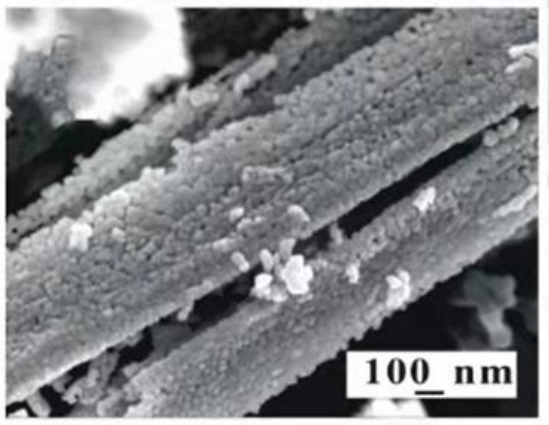
Figure 1. SEM images of thick film based on L-HP-SnO 2 microrods [42].